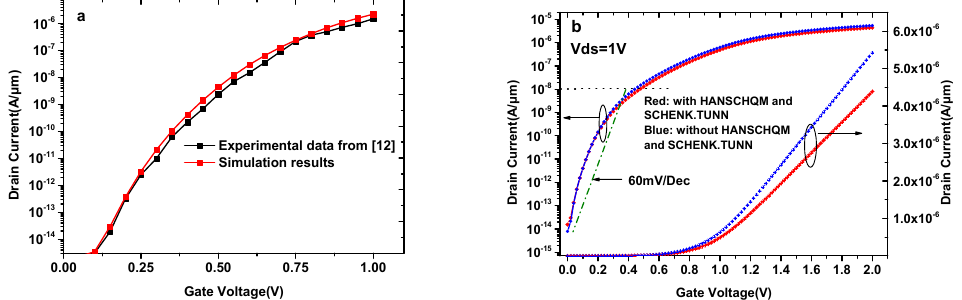
Figure 2. ( a ) Simulation models calibrated by reproducing the results of [12]. ( b ) Transfer characteristics of DMG-HJLTFET biosensor with and without HANSCHQM and SCHENK.TUN.